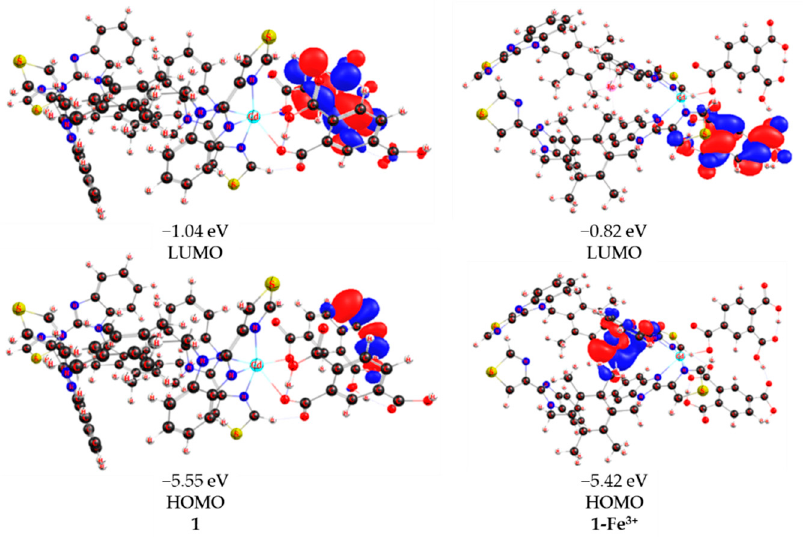
Figure 7. The geometrical structures and the energies and distributions of HOMO and LUMO for 1- Model and 1-Model-Fe 3+ were calculated with cam − B3LYP